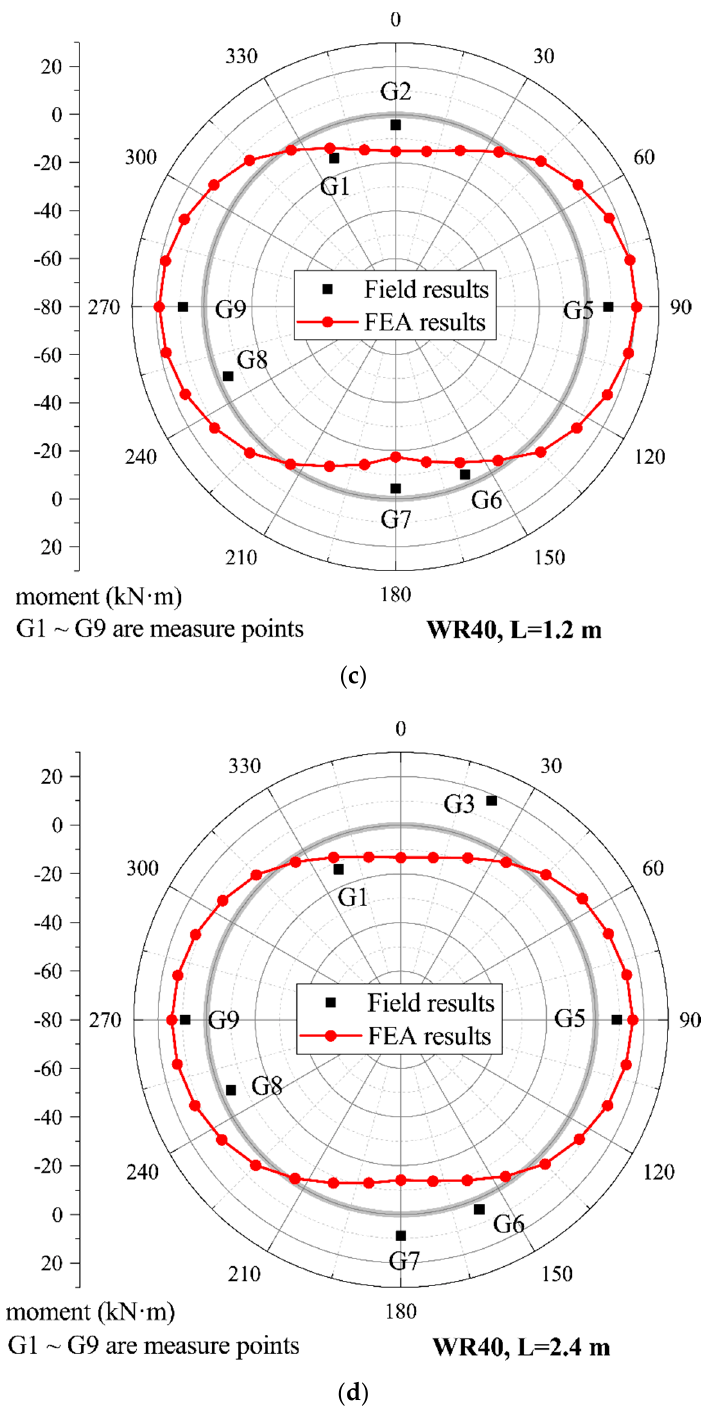
Figure 7. Results of field measurement and FEA modelling: ( a ) WR39, L = 1.2 m; ( b ) WR39, L = 2.4 m; ( c ) WR40, L = 1.2 m; and ( d ) WR40, L = 2.4 m.